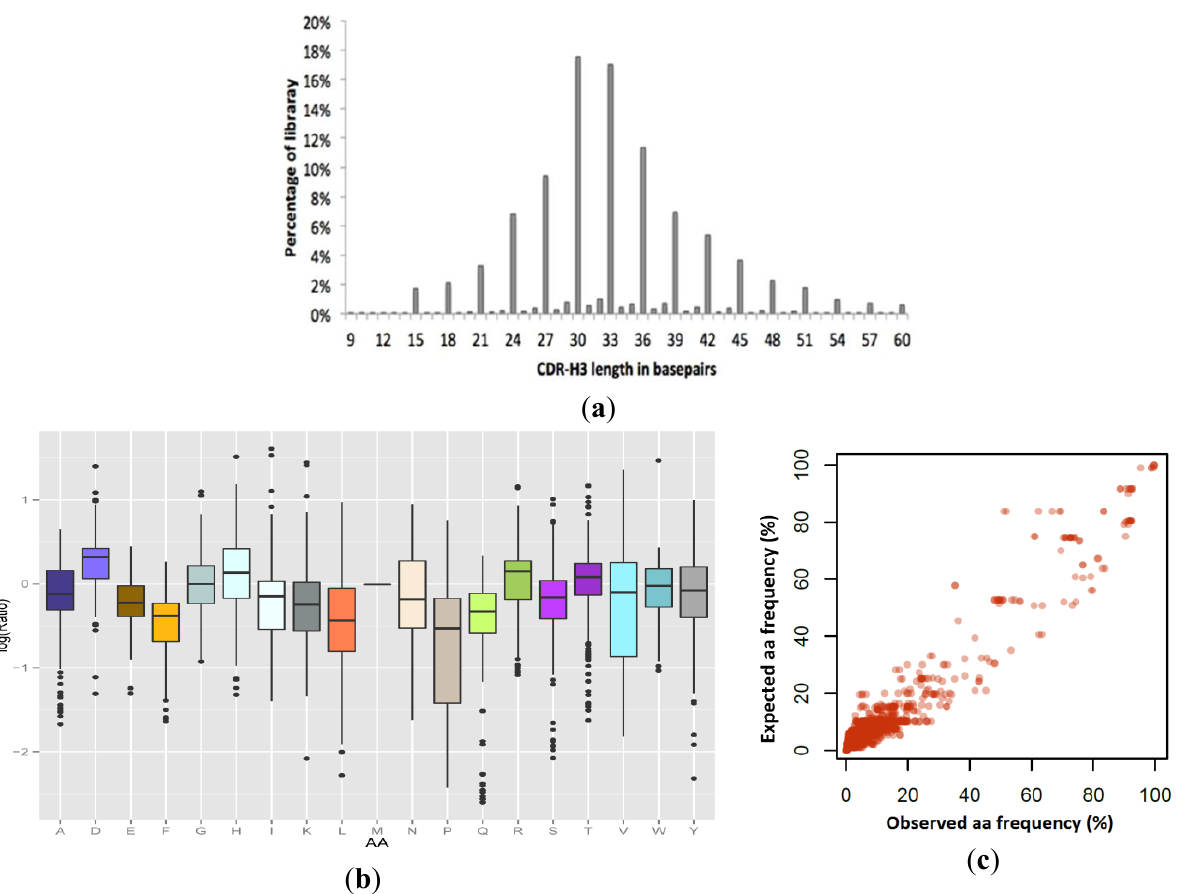
Figure 5. Colibra design fidelity in the final synthesized V HH library. ( a ) Observed CDR3 length distribution: 92% of the resulting library was observed in-frame. ( b ) and ( c ) Combination analysis of the amino acid incorporation efficiencies at 255 independent positions in the V HH library, as determined by high throughput sequencing, compared to expected values by